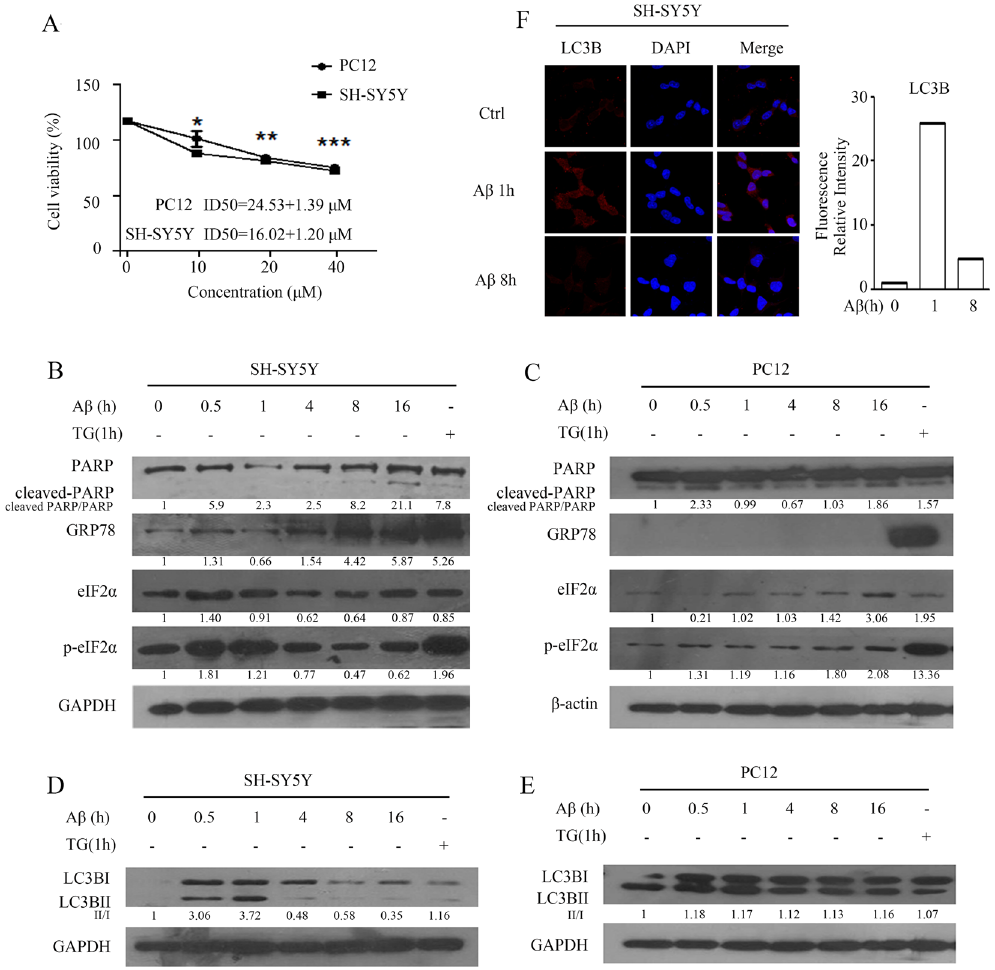
Figure 1. A β 25-35 induces apoptosis and autophagy in SH-SY5Y cells. ( A ) Different concentrations of A β 25-35 induce cell death. SH-SY5Y cells and PC12 cells. *** P < 0.001, ** P < 0.01, * P < 0.05 compared with negative- control cells. ( B , C ) Cells were treated with 20 μ M A β 25-35 for 0-16 h and TG for 1 h. Markers of ER stress (GRP78, phospho- eIF 2 α ) and apoptosis (PARP) were detected in cells by western blot. Figure B: SH-SY5Y cells; Figure C: PC12 cells. ( D , E ) Cells were treated with 20 μ M A β 25-35 for 0-16 h, and a marker of autophagy (LC3B) was detected in cells by western blot. Figure D: SH-SY5Y cells; Figure E: PC12 cells. ( F ) Cells were treated with 20 μ M A β 25-35 for 0-8 h. The red color indicates immunofluorescence staining of LC3B, showing levels of autophagy in cells. The blue color is DAPI, showing the cell nucleus. The right panel shows the merged images. The raw data of figure B/C/D/E is the figure 1B/1C/1D/1E in supplemental